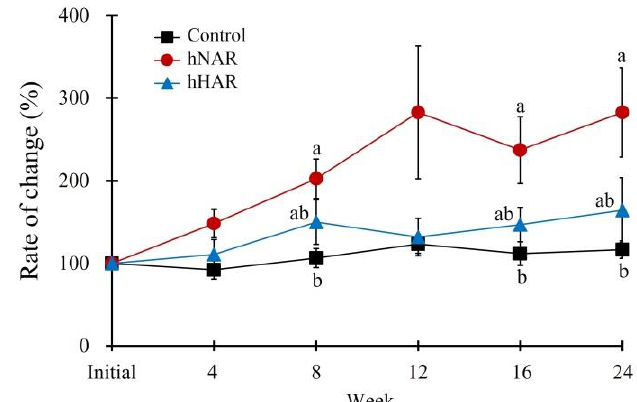
Figure 1. Effect of high-fat diet with high amylose type rice on the change in serum ALT levels in dogs (Exp. 1). Data are expressed as percent change compared to the initial value in each group. Control group, basal diet with 12% normal amylose type rice. hNAR group, high-fat diet with 12% normal amylose type rice. hHAR group, high-fat diet with 12% high amylose type rice. The different letters in same week denote significant differences among each group ( p < 0.05).